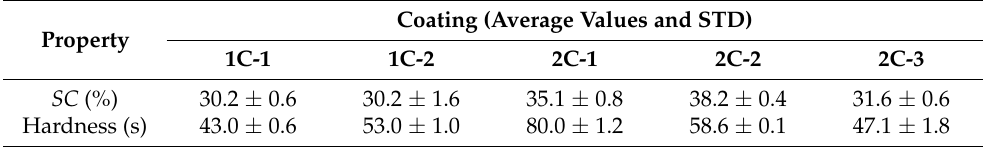
Table 2. Solids content ( SC ) content and coating hardness.